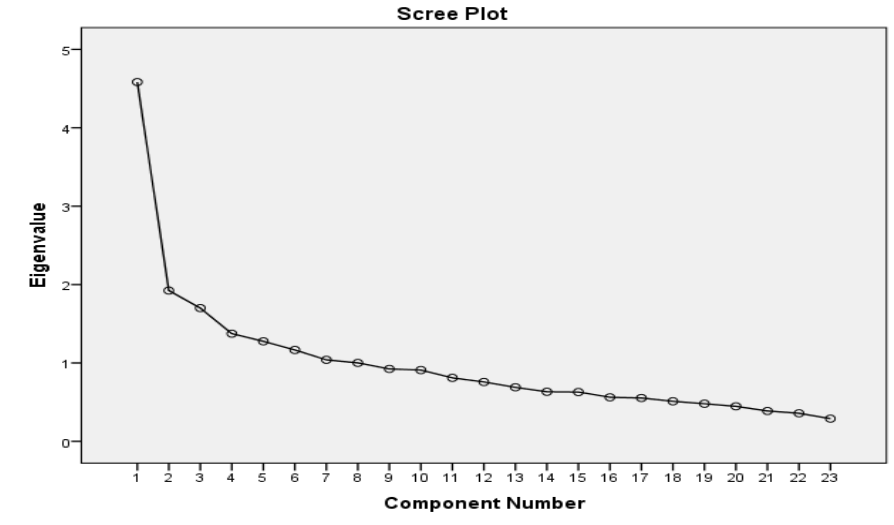
Fig. 1. The results of Scree plot